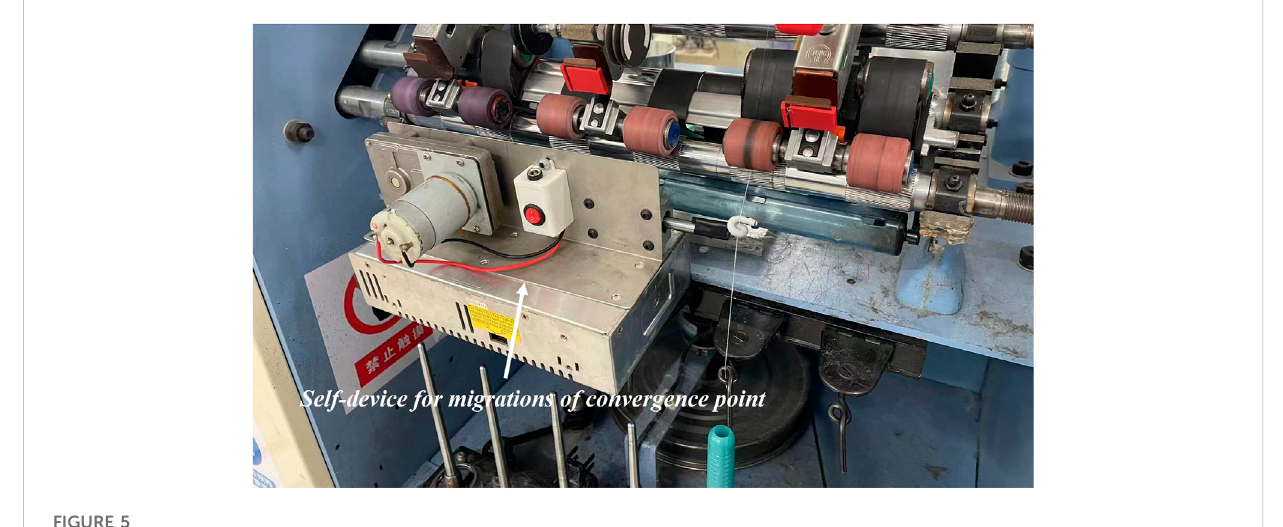
FIGURE 5 A simple homemade device for migrations of convergence